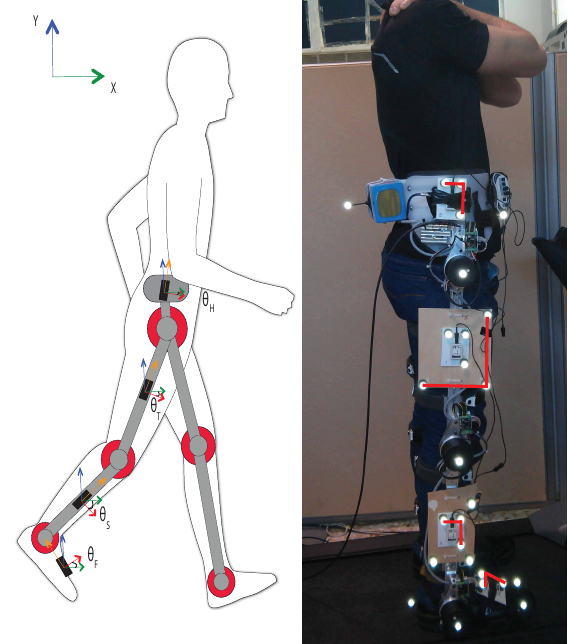
Figure 1. Experimental setup. The subject is wearing the H2-exoskeleton, with 6 actuated degrees of freedom and precision potentiometers at every joint. Optical markers as well as inertial sensors are placed on all lower limb segments. A total of 4 inertial sensors are attached to the right leg. The markers used in this analysis are connected by red